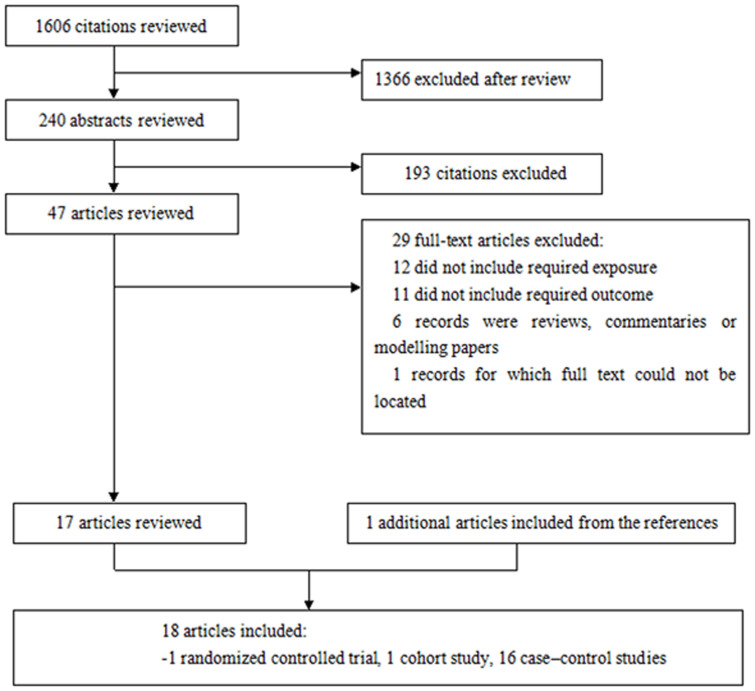
Study selection procedures for a meta-analysis of maternal folate supplementation and the risk of congenital heart defects (CHDs) in offspring.